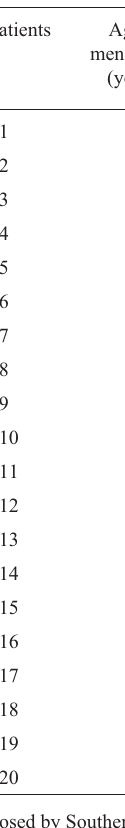
*Premutation diagnosed by Southern